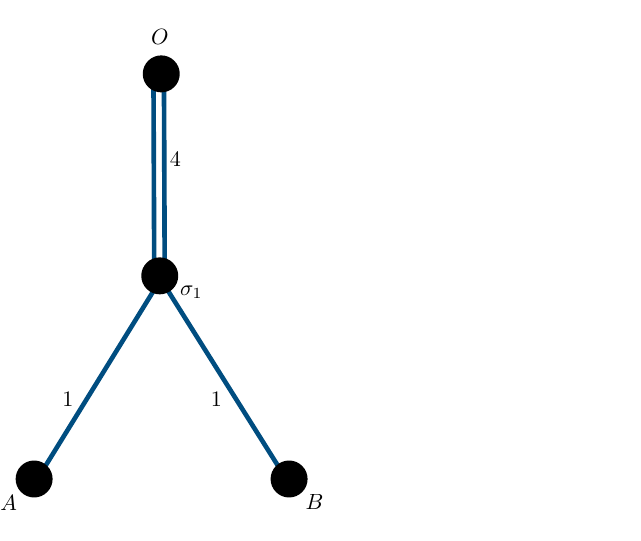
Figure 19 . The maximal thread configuration of (6.25) for the graph g has an entropy vector = { 1 , 1; 2 } or K 2 = { 0 , 1 , 1 } which matches that of the graph and obtains a value of 2 ∗ 2 = 4 . S 2 µ µ The barrier configuration is given by a barrier of two on the edges e 2 ∗ 2 = 4 . Here α = α = 0 while α = 2 so that each AB 2-thread is required to cross an increased 2 3 1 barrier of exactly 4. This is consistent as the only saturated entropy inequality is K by theorem 4 only α is 1